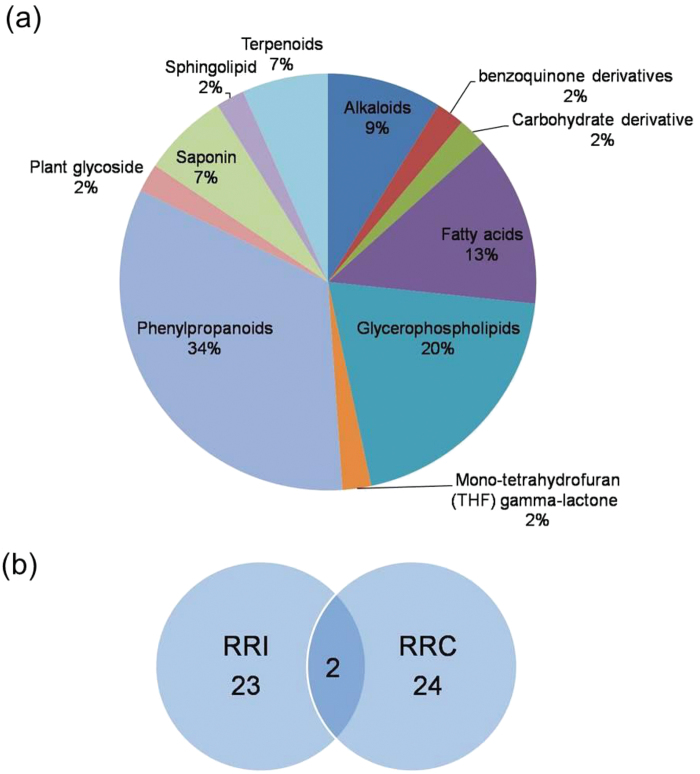
Analysis of resistance-related (RR) metabolites. (A) Classification of RR metabolites according to chemical groups. (B) Venn diagram showing number of RR metabolites (>2-fold) identified in the spikelets of barley cultivar CI9831, where spikelets were inoculated with water or F. graminearum spores. RRI, resistance-related induced metabolites; RRC, resistance-related constitutive metabolites. A colour version of this figure is available at JXB online.